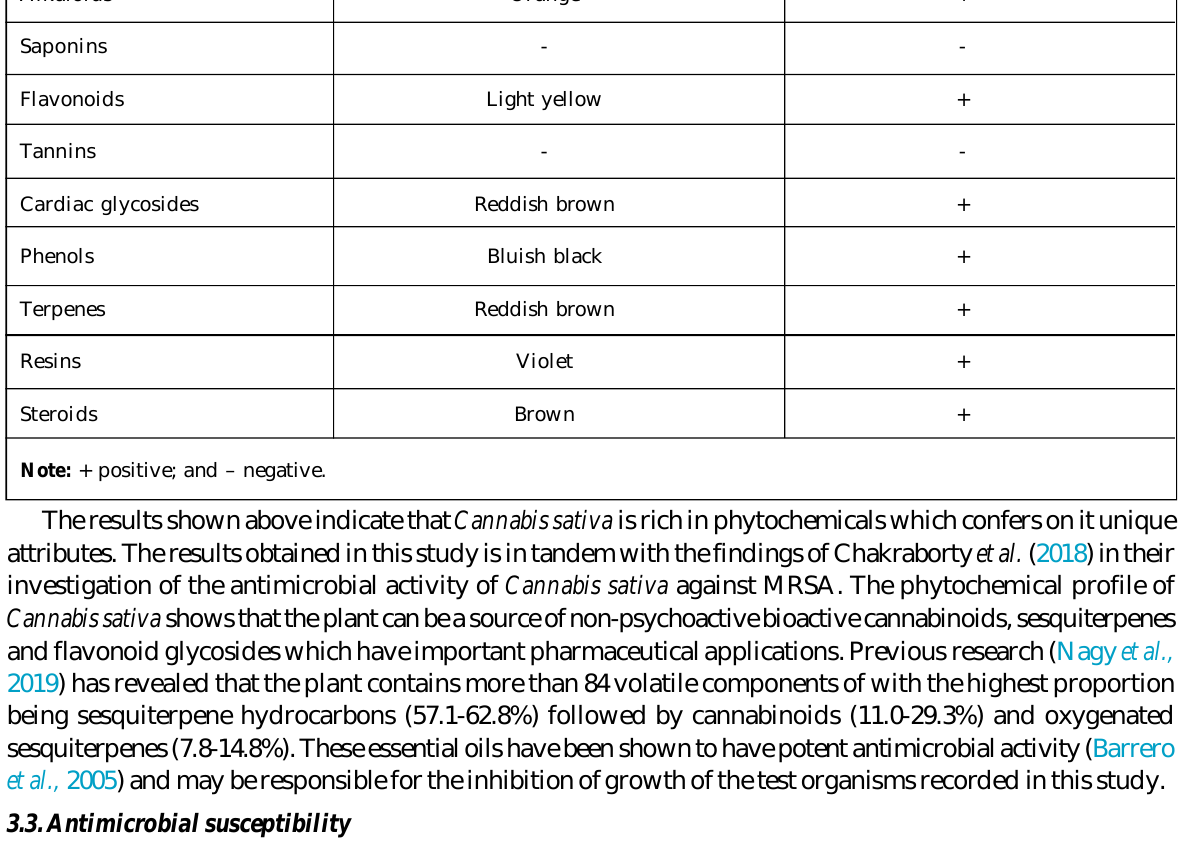
Table 1: Phytochemical analysis of methanolic extracts of Cannabis sativa Phytochemical Color Presence Alkaloids Orange + Saponins - - Flavonoids Light yellow + Tannins - - Cardiac glycosides Reddish brown + Phenols Bluish black + Terpenes Reddish brown + Resins Violet + Steroids Brown